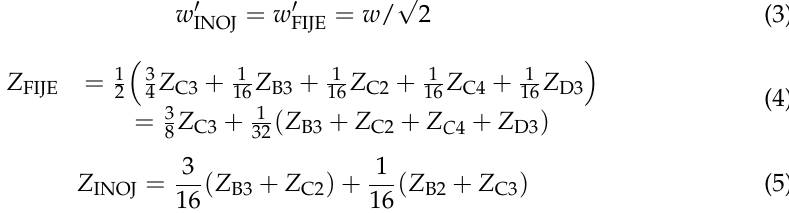
Figure 5. Virtual pixel subdivision methods: ( a ) the average interpolation method; ( b ) the CR method [33]; and ( c ) the SCR